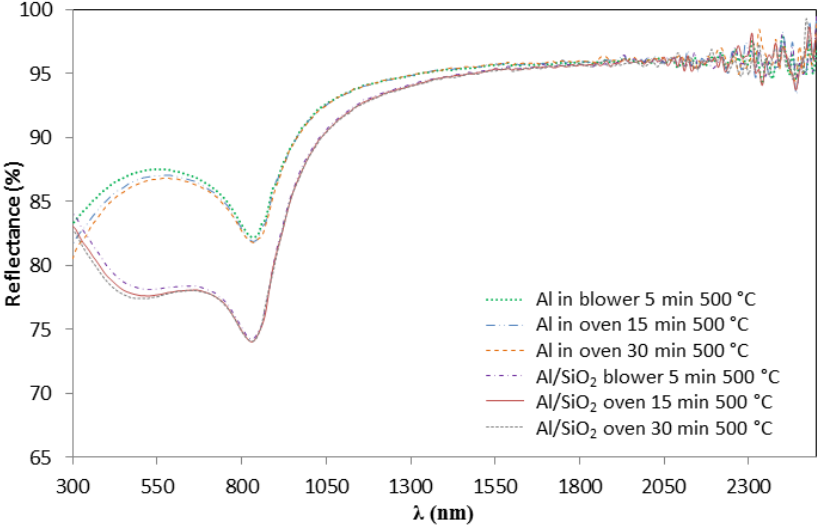
Figure 6. Effect of the SiO 2 sintering conditions on the bare Al substrate and Al/SiO 2 samples on the hemispherical reflectance measurements.